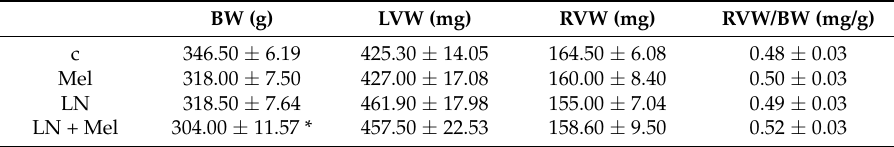
Values are mean ± S.E.M., * p < 0.05 vs. c.